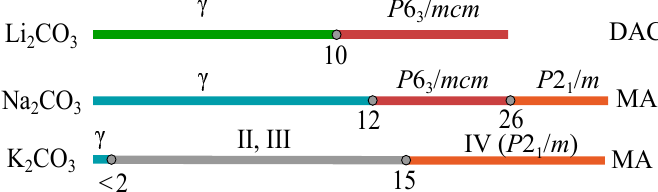
Figure 11. Scheme, summarising experimental data on high-pressure phase transitions of Li 2 CO 3 [54], Na 2 CO 3 (this work) and K 2 CO 3 (this work). Numbers show pressures oh phase transitions in GPa. Similar crystal structures are shown in the same colours.